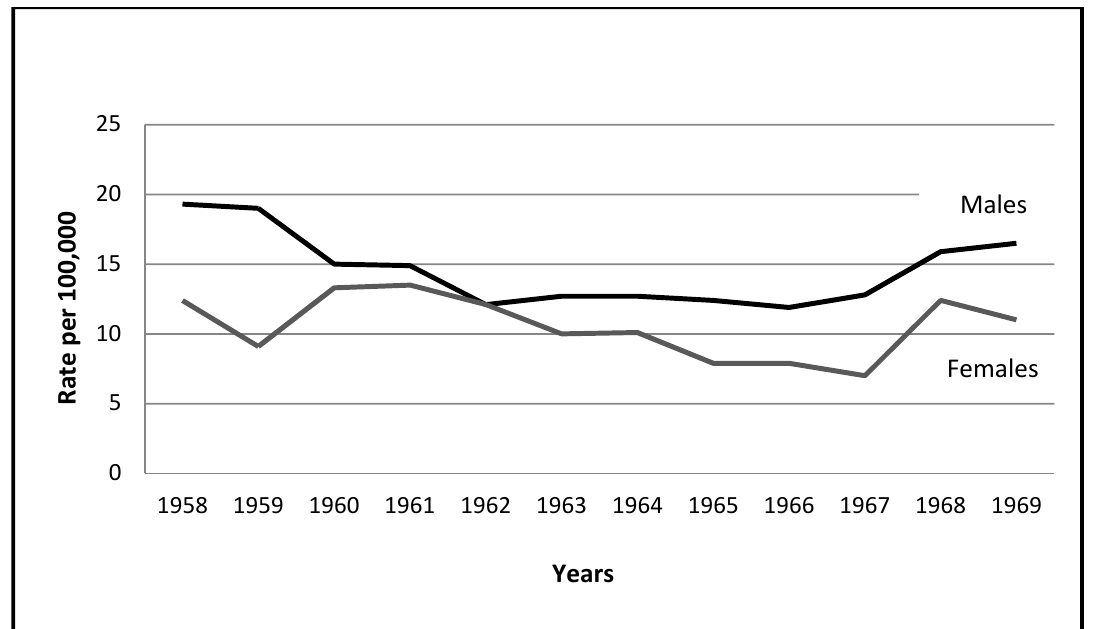
Figure 1. Time-plot: The Six-Day War